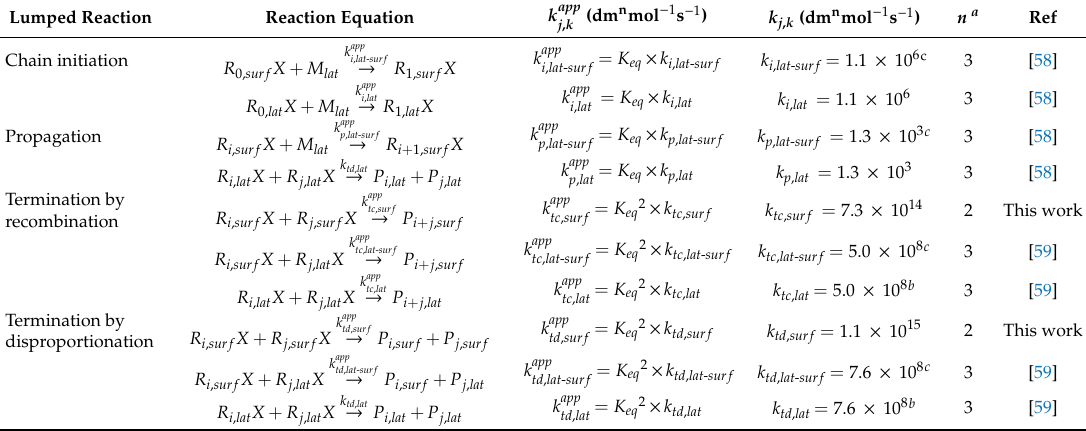
Table 1. Lumped chemical reactions to model surface-initiated reversible deactivation radical polymerization (SI-RDRP; formally case of normal SI-ATRP) by means of kinetic Monte Carlo (kMC) simulations. Also given are the lumped apparent rate coe ffi cients ( k app ) and the associated elementary j , k rate coe ffi cients ( k j , k ) to calculate these k app values; j : reaction type; k ; phase (surf, lat, lat-surf); the j , k equilibrium coe ffi cient ( K eq ) for the calculation of k app values is for simplicity always 1.5 × 10 − 6 ; for j , k reactions on the surface the actual MC rate in s − 1 (Equations (14)–(16)) is further corrected as described in Section 2.2 to take into account the impact of confinement on the kinetics (availability of space and reactive center(s) at reaction distance). k j , k values used in this work are based on the polymerization